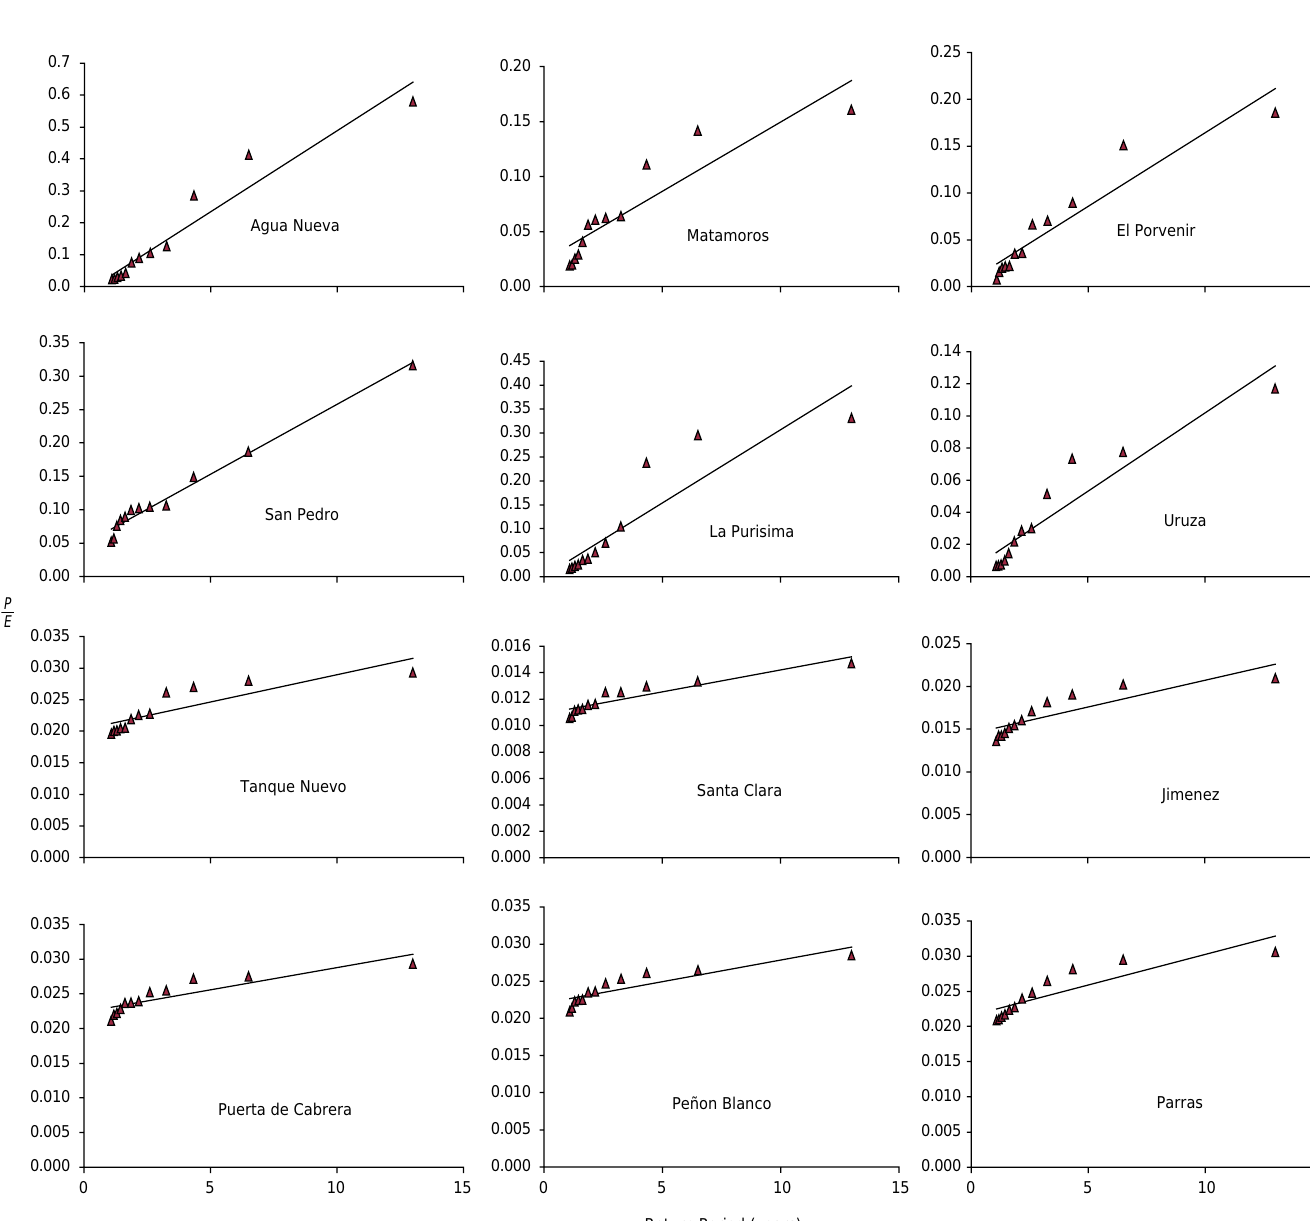
Figure 4. Magnitude-frequency of the P parameter for the weather stations considered in the study. Note that the vertical scale E (y-axis) is different for each weather station because of the magnitude of the